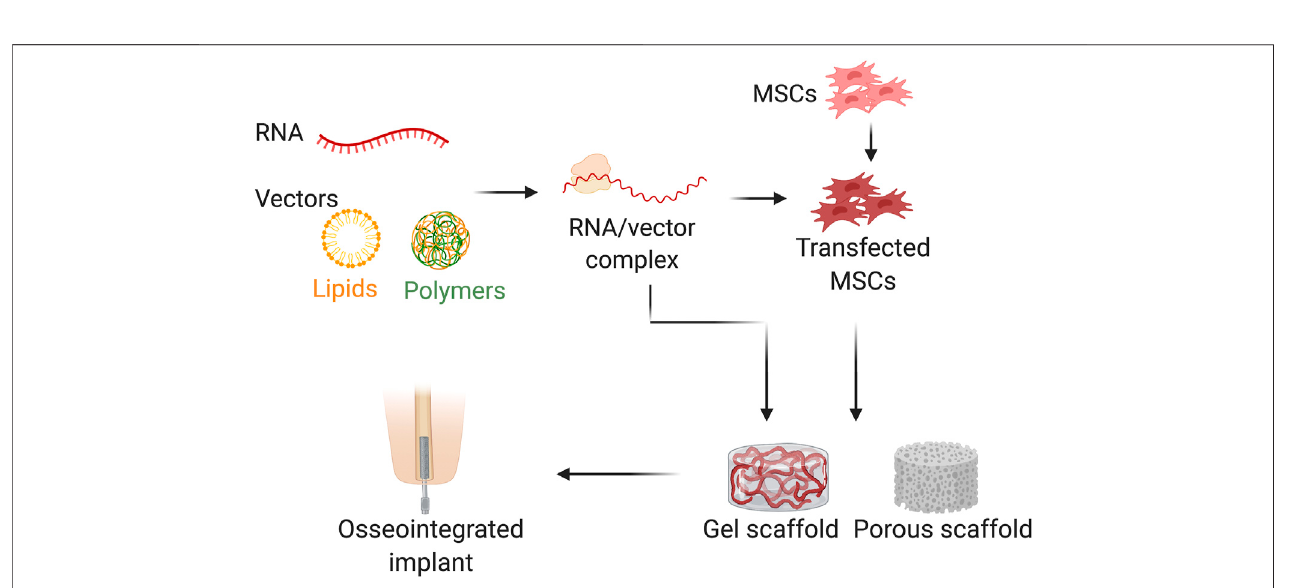
FIGURE 3 | Schematic illustration of RNA delivery method used for bone osteointegration. RNA was combined with vector (e.g., lipids and polymers) and/or transfecting the MSCs before loaded to the scaffolds (e.g., gel or porous scaffolds) (Created with